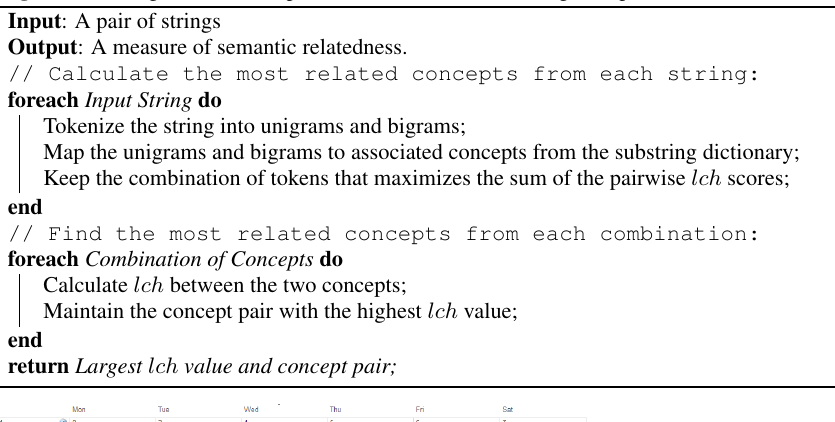
Algorithm 2: Algorithm to compute semantic relatedness using Wikipedia-derived data.